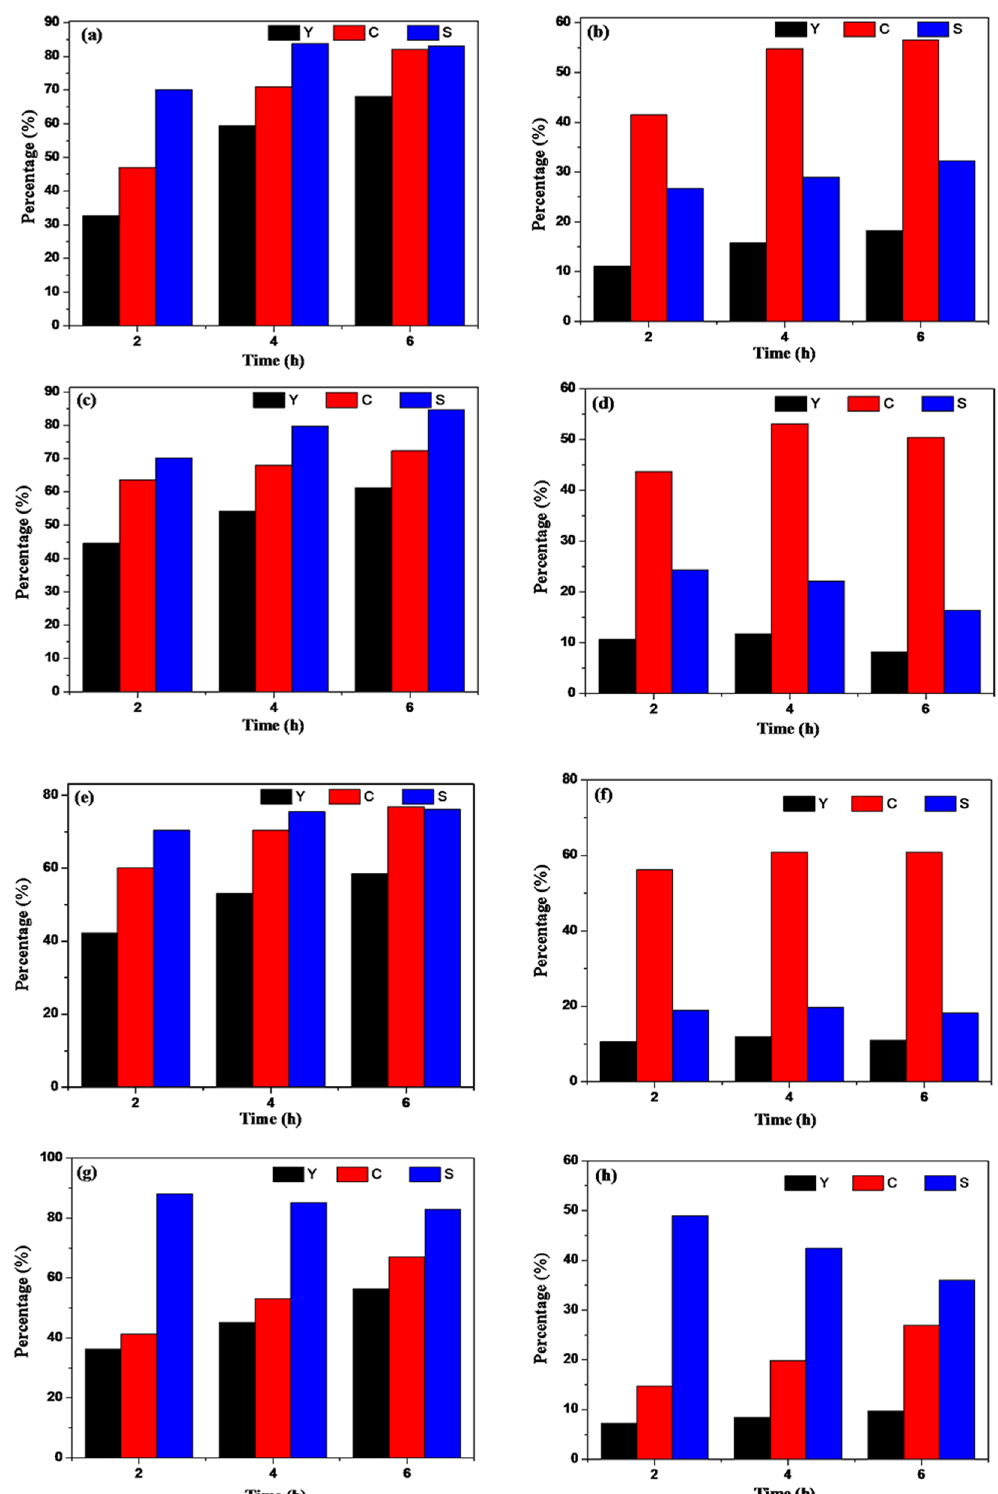
Figure 10. Photocatalytic performance of CdIn 2 S 4 photocatalyst for selective oxidation of aromatic alcohols to aldehydes ( a, c, e and g ) and reduction of nitrobenzene into aniline ( b, d, f and h ) under visible light irradiation ( λ > 420 nm) for different times in N 2 purge condition. ( a ) p-methoxybenzylalcohol, ( b ) corresponding nitrobenzene; ( c ) p-chlorobenzylalcohol, ( d ) corresponding nitrobenzene; ( e ) p-fluorobenzyl alcohol, ( f ) corresponding nitrobenzene; ( g ) p-tolylmethanol, ( h ) corresponding